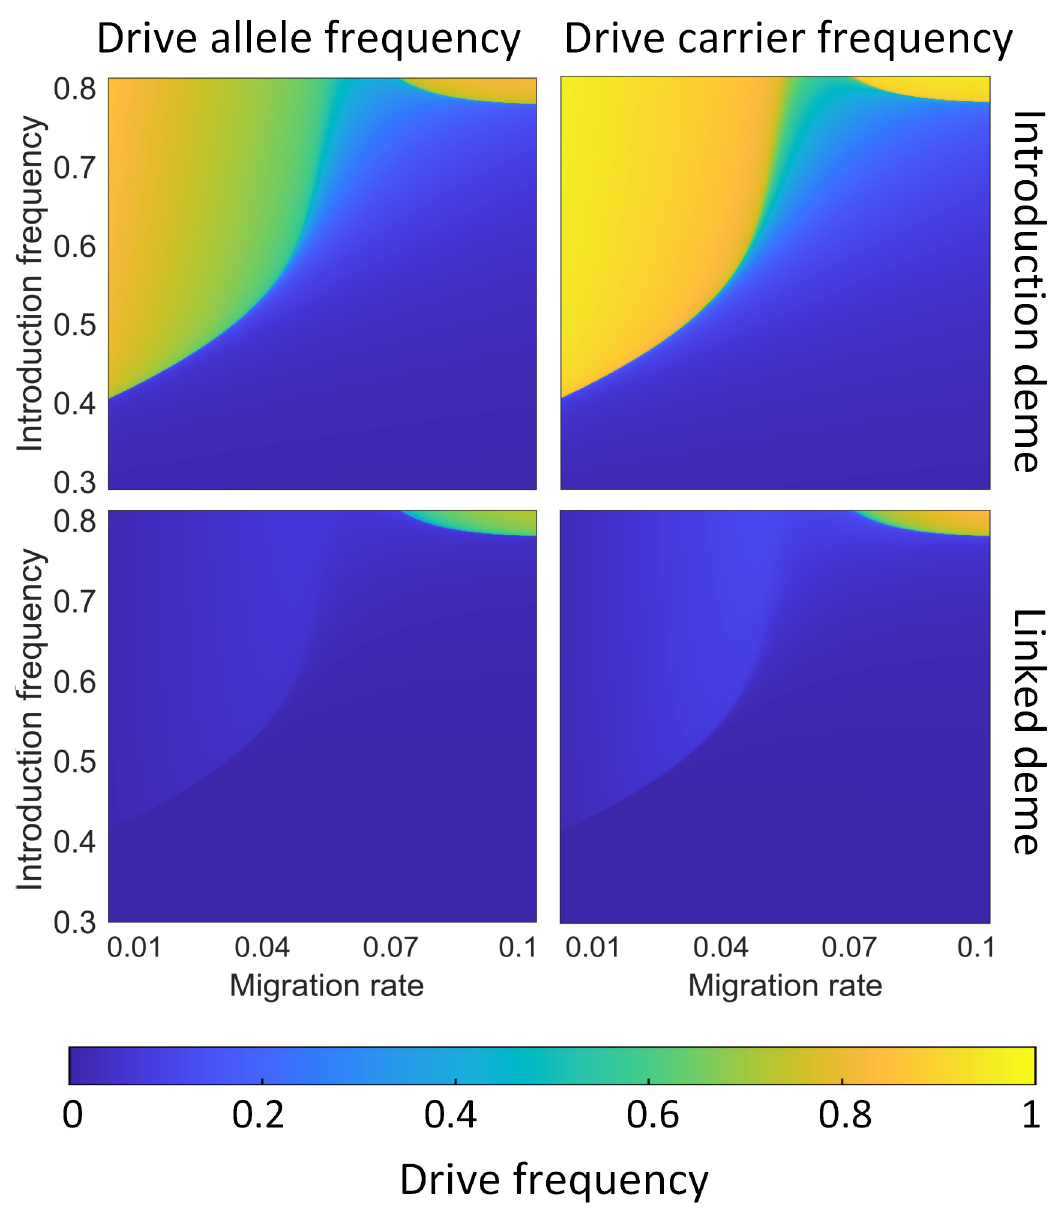
Fig 3. Confinement of the CifAB drive in a scenario with two linked demes. We show the average allele and carrier frequencies of the CifAB drive in the first 100 generations after adding drive individuals in both the introduction deme and the linked deme. Blue colors represent areas of the parameter space where the drive is lost or where it fails to invade the second deme and is present only at a low equilibrium frequency.